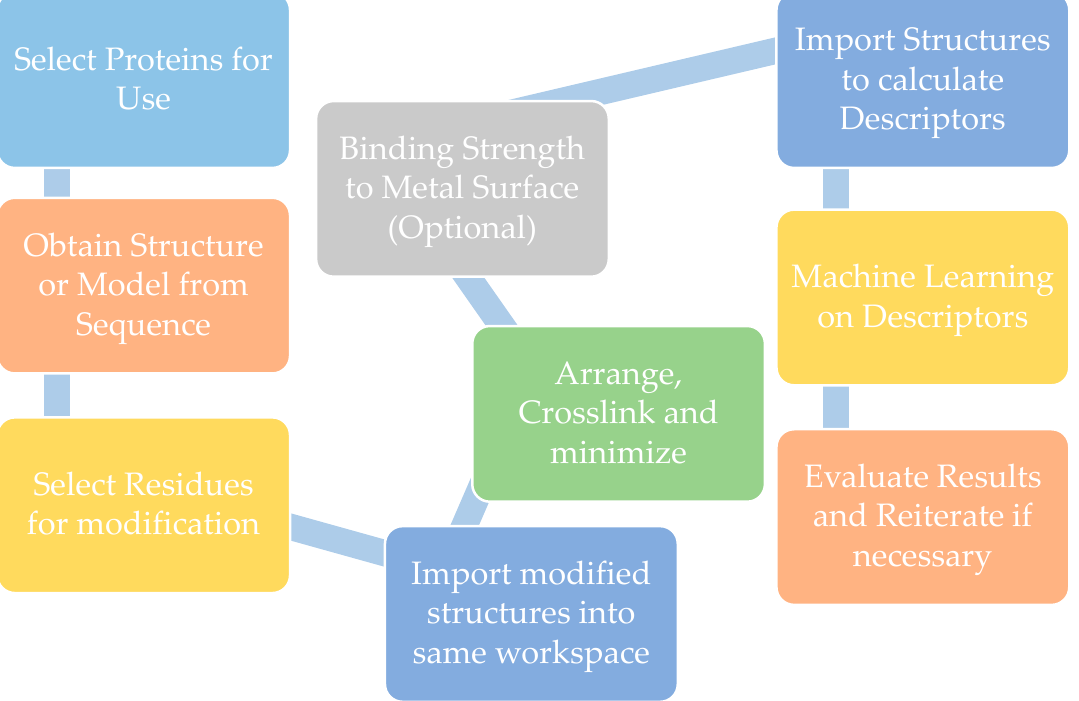
Figure 5. Workflow for evaluating protein coatings for titanium surface.